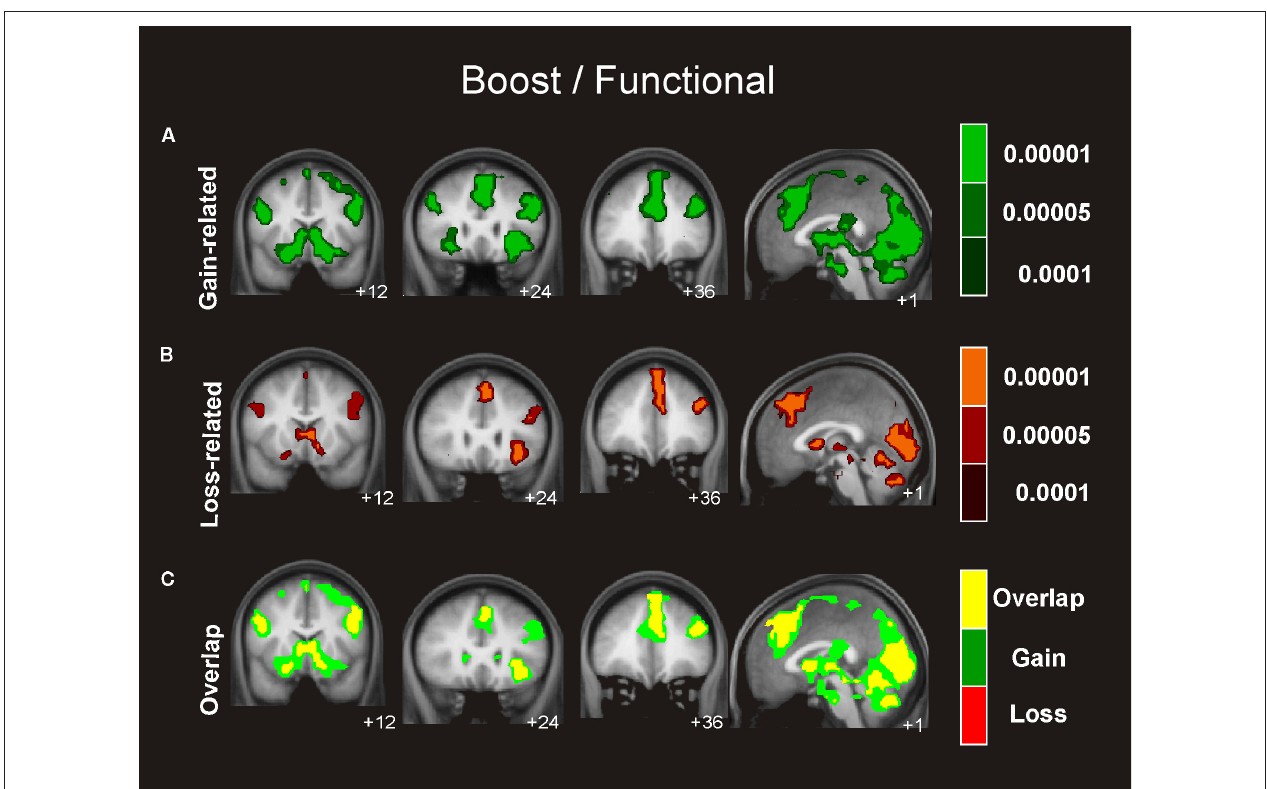
fi xation contrast (B) using different statistical thresholds ( P < 0.0001; P < 0.0005; P < 0.001). Gain and loss patterns are simultaneously represented in (C) : gain (green, P < 0.001), loss (red, P < 0.001), and conjunction gain (cid:2) loss (yellow, P < 0.001 and P <